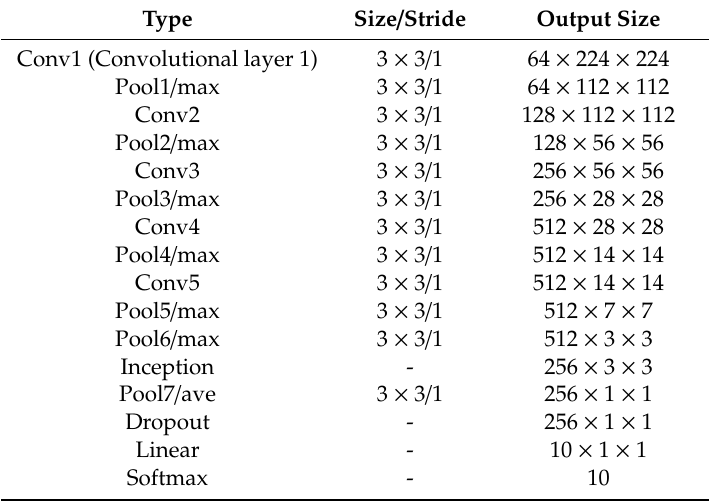
Table 2. Related parameters of the convolutional neural network (CNN)-based